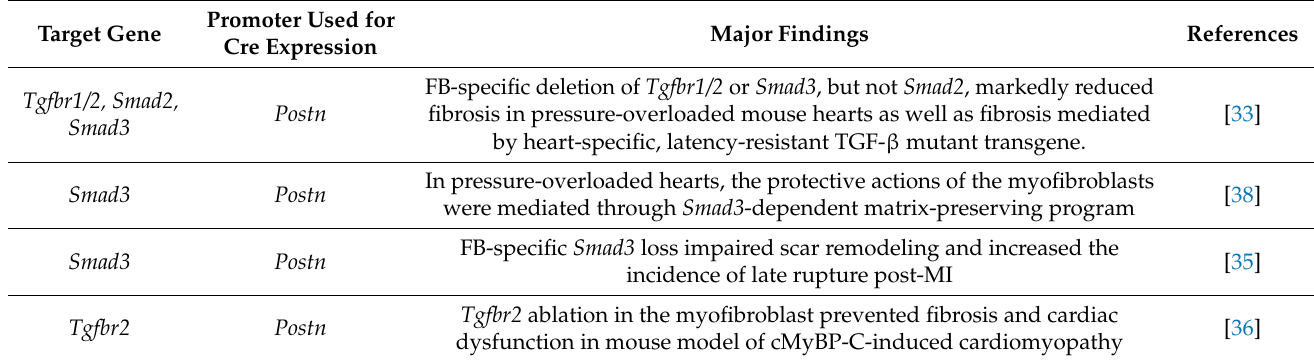
Table 2. Studies carried out with FB-specific, genetically manipulated mouse